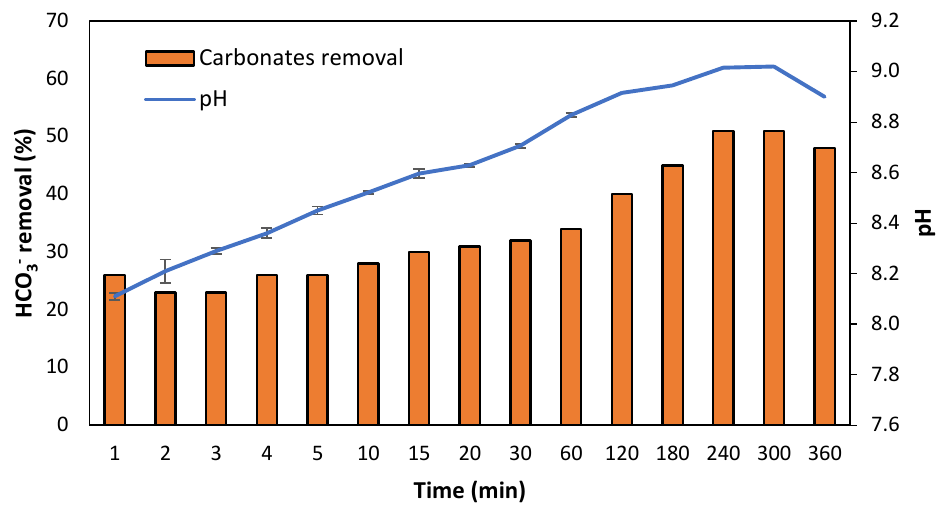
Figure 4. Variation of pH and the efficiency of HCO 3 − removal with time in the aeration stage.